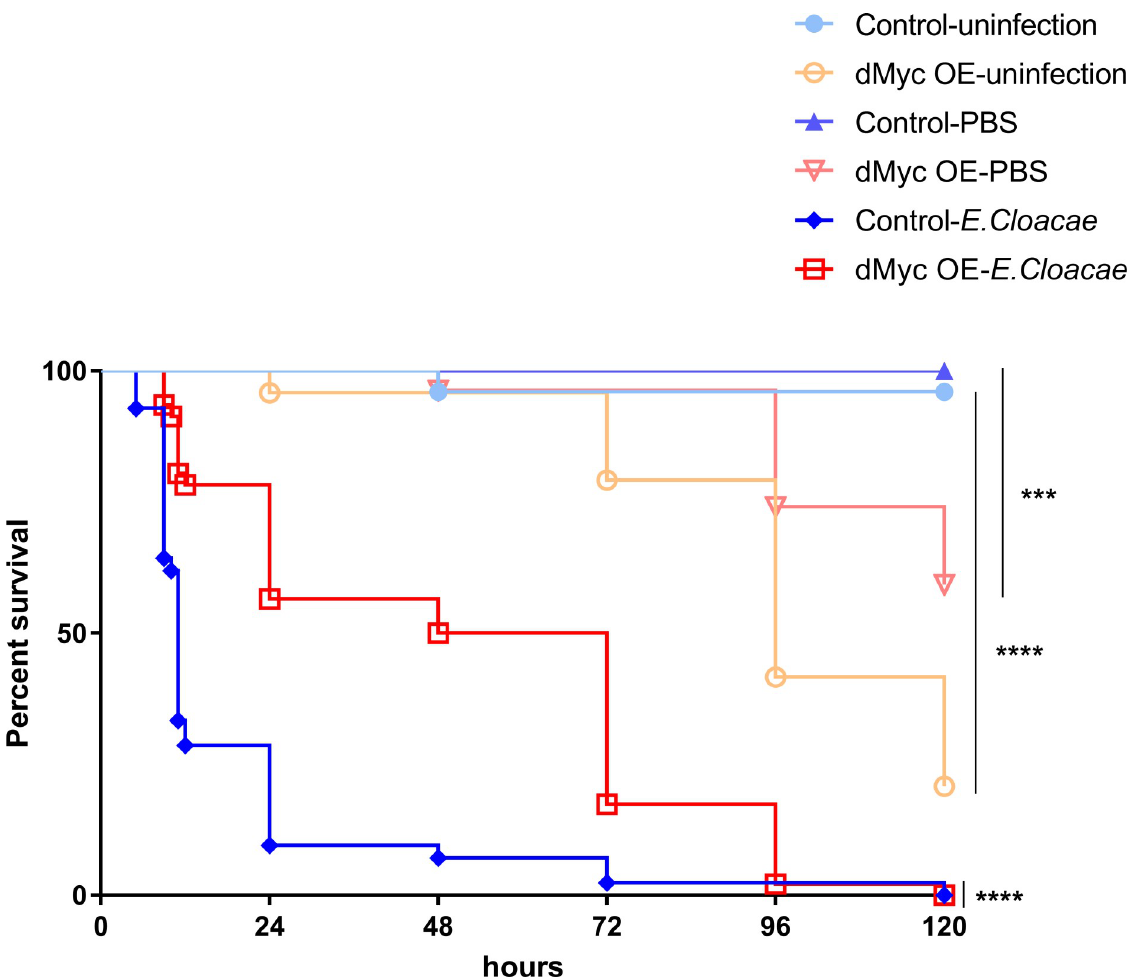
Fig 8. The ectopic expression of dMyc influences the survival of Drosophila . The changes of the survival rate were observed in dMyc highexpressed flies and the control (Gal80 ts ;Tub-Gal4/+) flies without infection and with PBS as well as E . cloacae infection; dMyc OE (overexpression): Gal80 ts ;Tub >